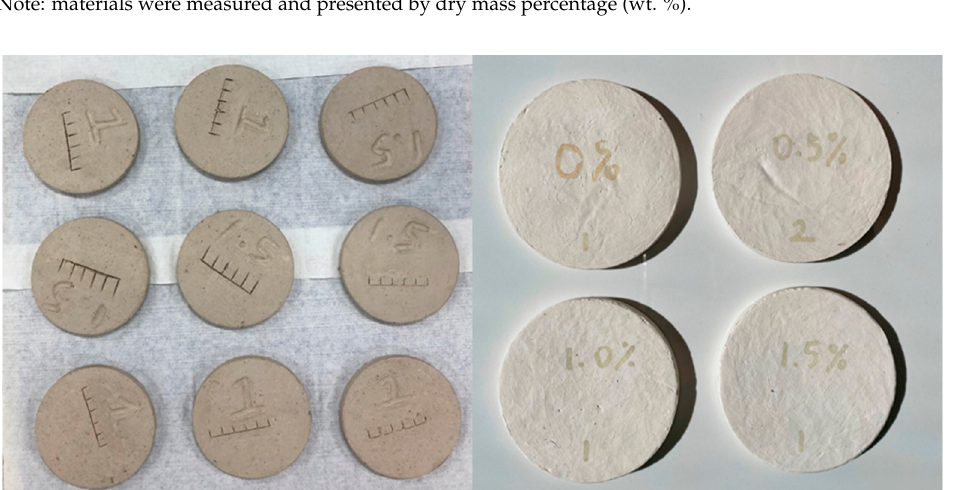
Table 2. The ratios of raw materials for ceramic mixtures. Table 3. The firing schedule.